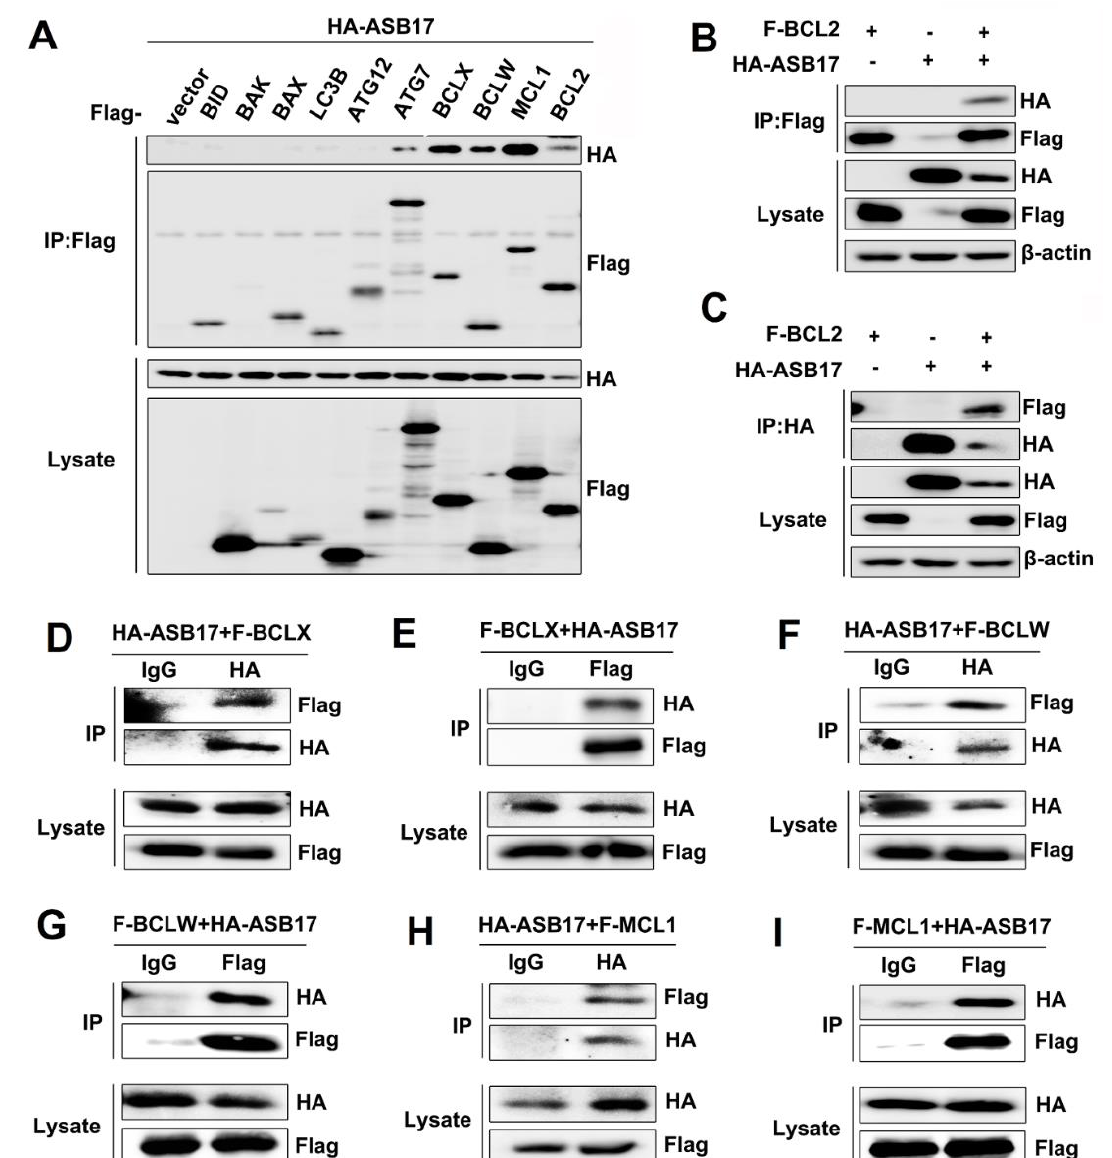
Figure 6. ASB17 interacts with BCL2, BCLX, BCLW, and MCL-1. ( A ) HEK293T cells were transiently co-transfected with the control plasmids, Flag-BID, Flag-BAK, Flag-BAX, Flag-LC3B, Flag-ATG12, Flag-ATG7, Flag-BCLX, Flag-BCLW, Flag-MCL1, or Flag-BCL2 together with HA-ASB17. The cell lysates were immunoprecipitated with an anti-Flag antibody followed by anti-HA immunoblotting. ( B , C ) HEK293T cells were transiently co-transfected with HA-ASB17 and control plasmids, Flag-BCL2 and control plasmids, or HA-ASB17 and Flag-BCL2 plasmids, respectively, and analyzed by immunoprecipitation (IP) with an anti-Flag ( B ) or anti-HA antibody ( C ) and immunoblotting (IB) with indicated antibodies. ( D , E ) HEK293T cells were transiently co-transfected with HA-ASB17 and Flag-BCLX. The cell lysates were immunoprecipitated with an anti-IgG and anti-HA ( D ) or anti-Flag ( E ) antibody followed by immunoblotting with indicated antibodies. ( F , G ) HEK293T cells were transiently co-transfected with HA-ASB17 and Flag-BCLW. The cell lysates were immunoprecipitated with an anti-IgG and anti-HA ( F ) or anti-Flag ( G ) antibody followed by immunoblotting with indicated antibodies. ( H , I ) HEK293T cells were transiently co-transfected with HA-ASB17 and Flag-MCL1. The cell lysates were immunoprecipitated with an anti-IgG and anti-HA ( H ) or anti-Flag ( I ) antibody followed by immunoblotting with indicated